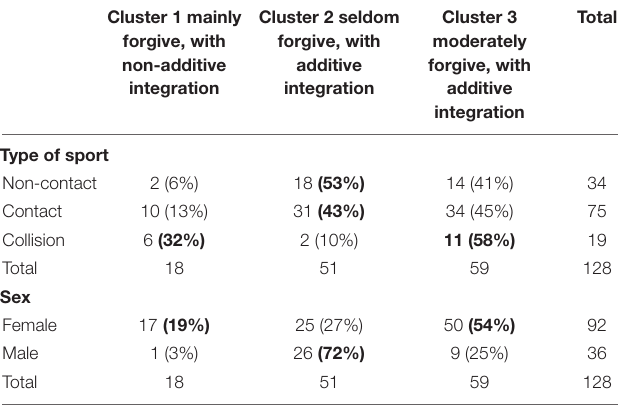
TABLE 3 | Composition of the clusters, with regard to the participants’ type of sport and sex. Cluster 1 mainly Cluster 2 seldom Cluster 3 forgive, with forgive, with moderately non-additive additive forgive, with integration integration